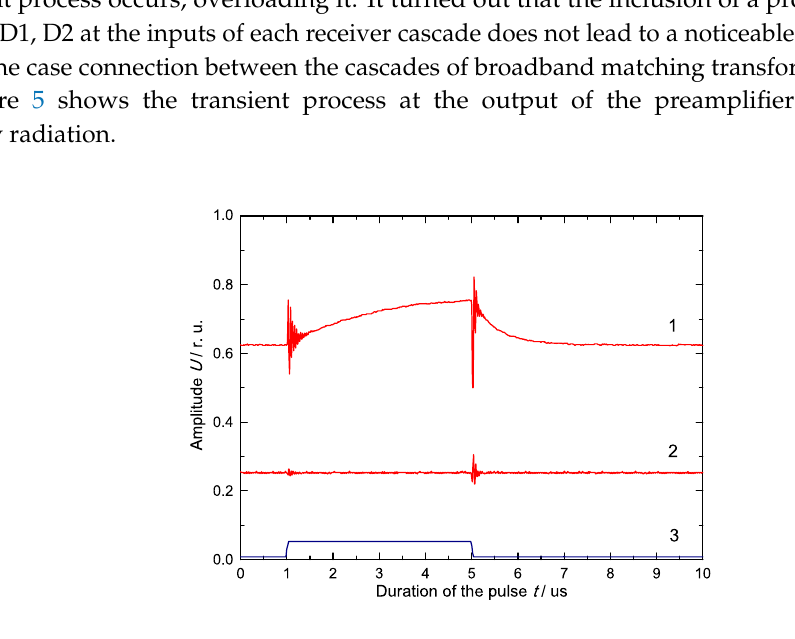
Figure 5. Transient process in the spin signal amplifier: ( 1 ) Without a suppression circuit; ( 2 ) With the application of the proposed transient suppression circuit; ( 3 ) Gating pulse.